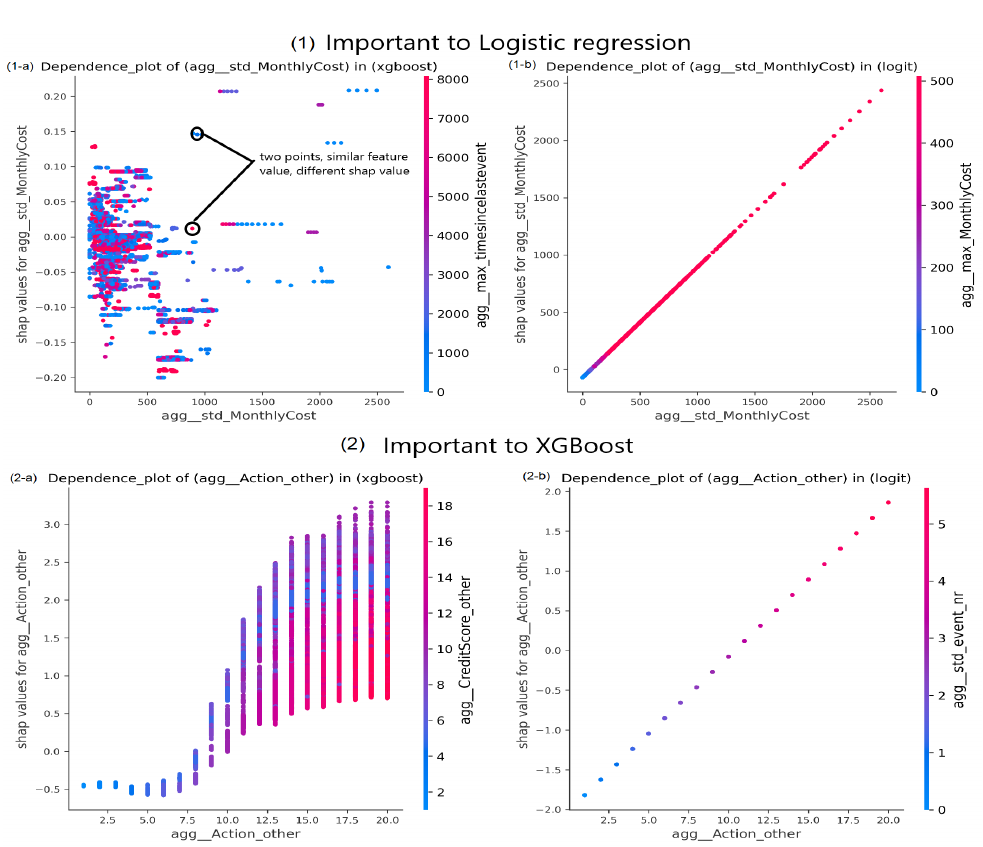
Figure 10. SHAP Dependence plots of BPIC2017_Accepted event